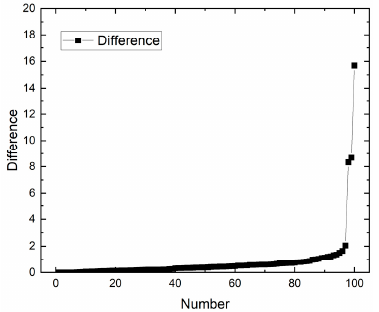
Figure 11. Difference between Jaccard and SWR.